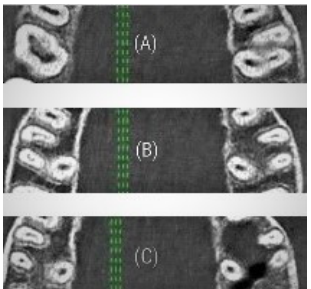
Figure 4. Changed cross-sectional root canal shape for maxillary first molar from ribbon shape in the coronal third to oval in the middle and apical thirds for MB root. (( A ): refers to coronal third, ( B ): middle third, ( C ): apical third of root canal).